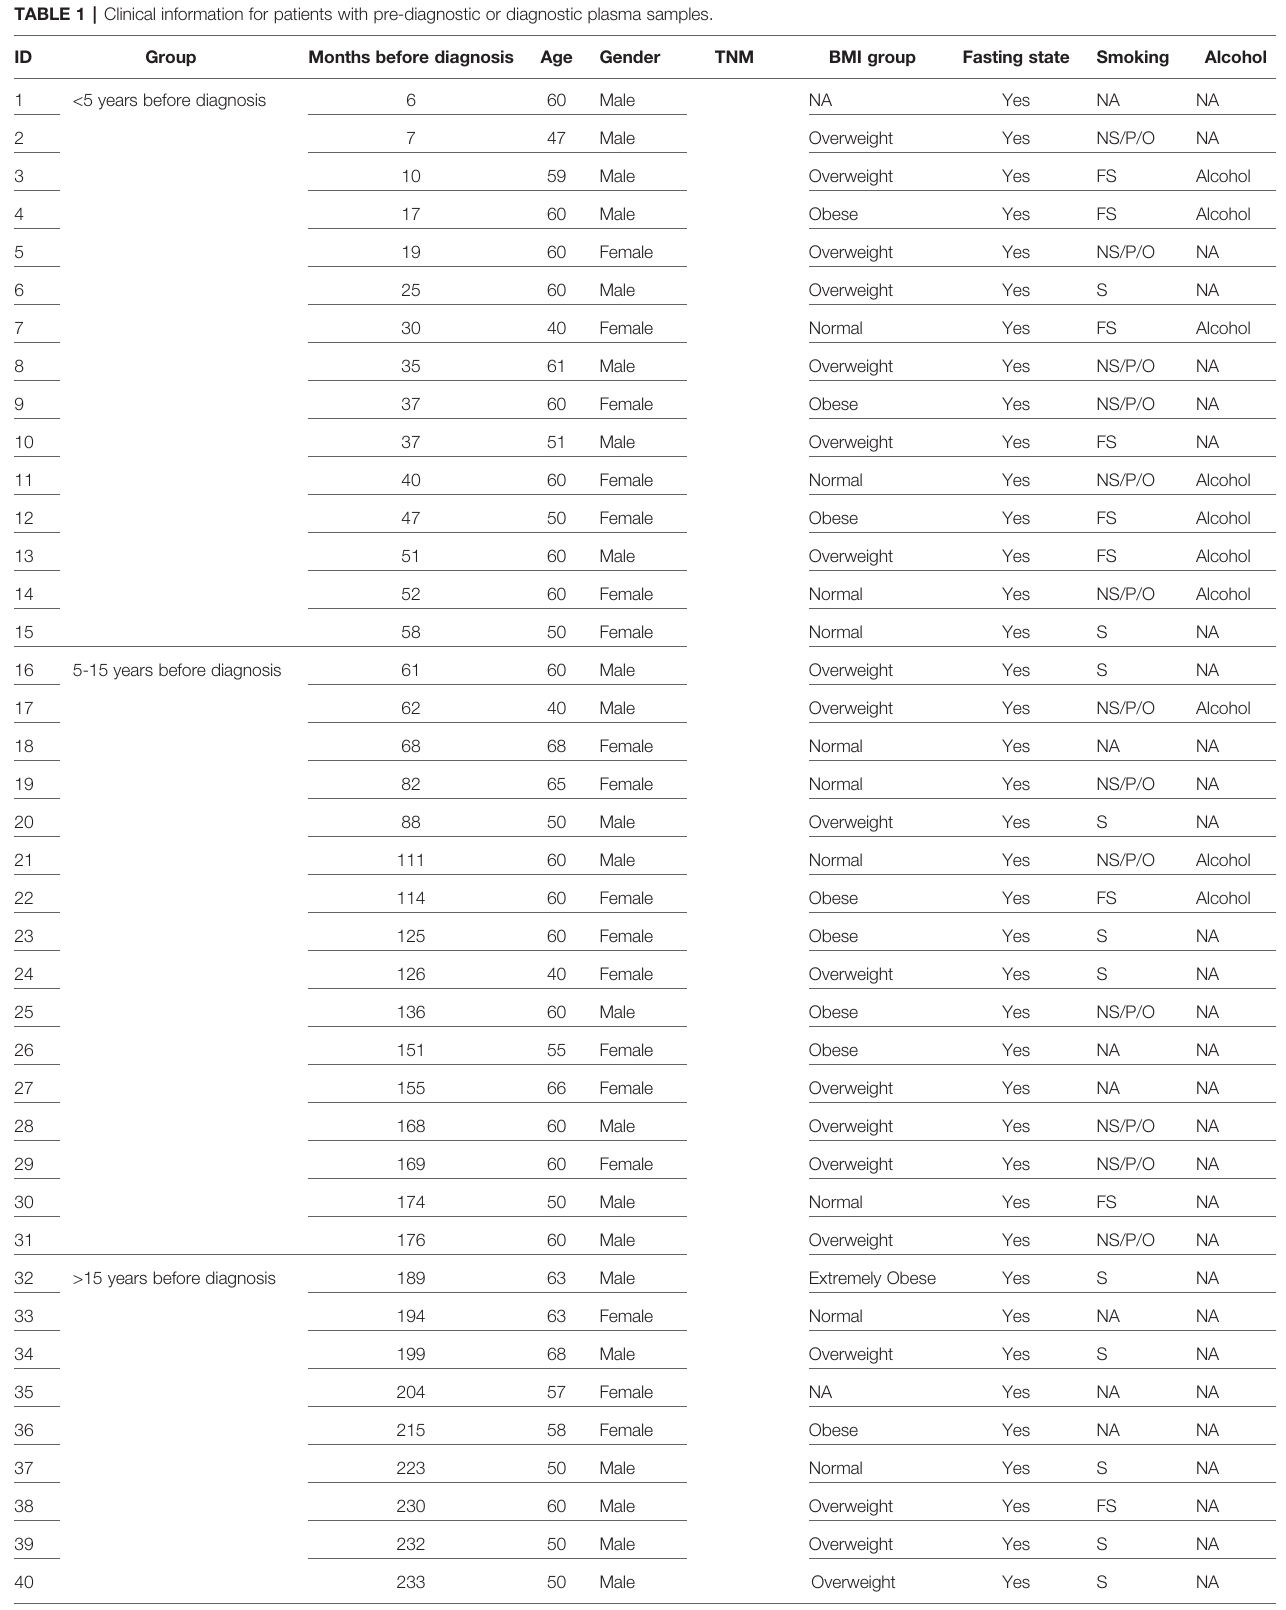
TABLE 1 | Clinical information for patients with pre-diagnostic or diagnostic plasma